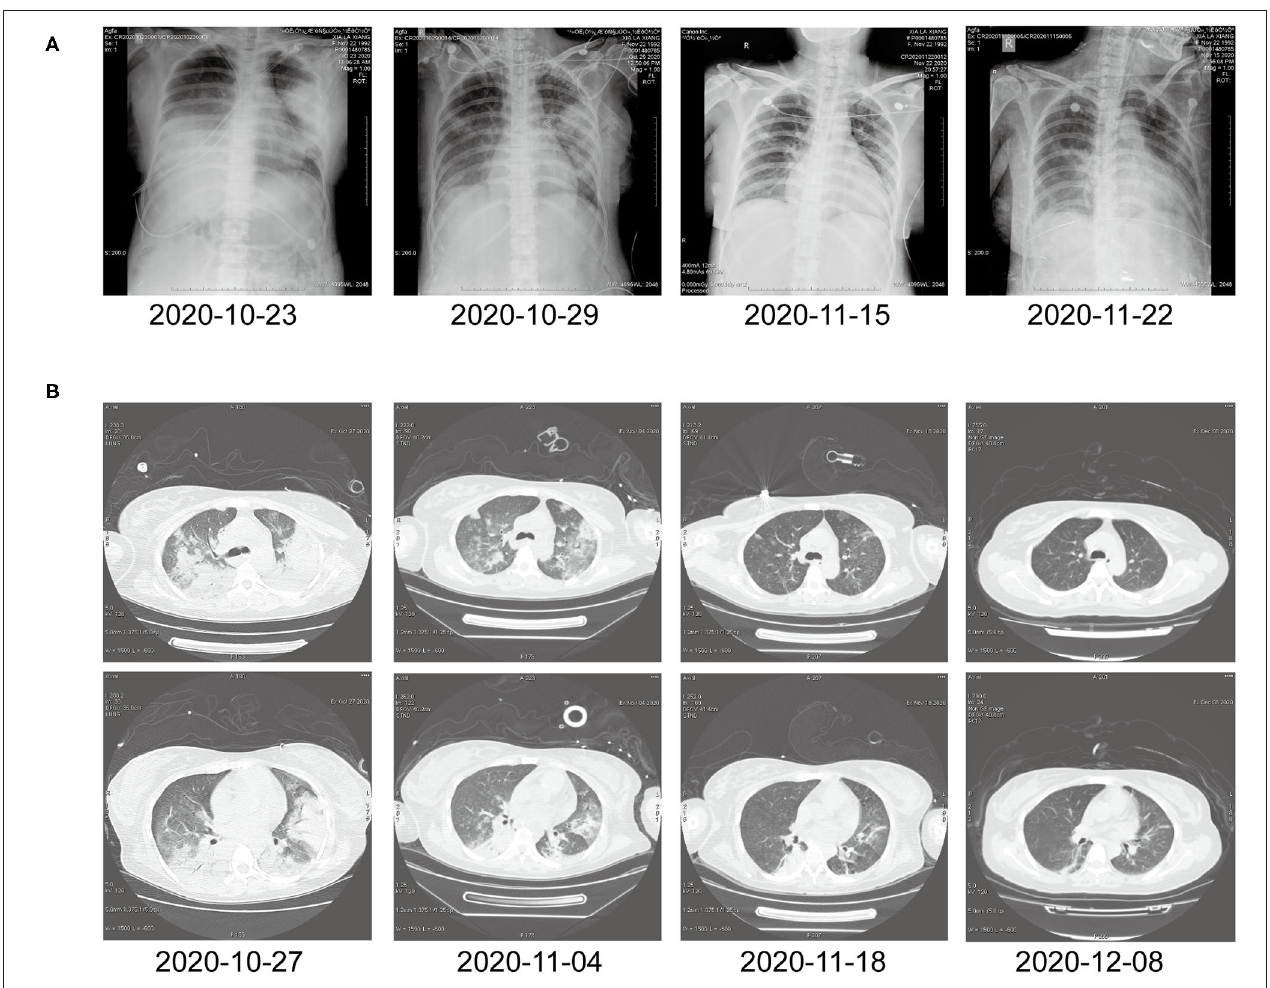
FIGURE 1 | (A) Chest X-ray before and after treatment. (B) Chest computed tomography at different time points after treatment.